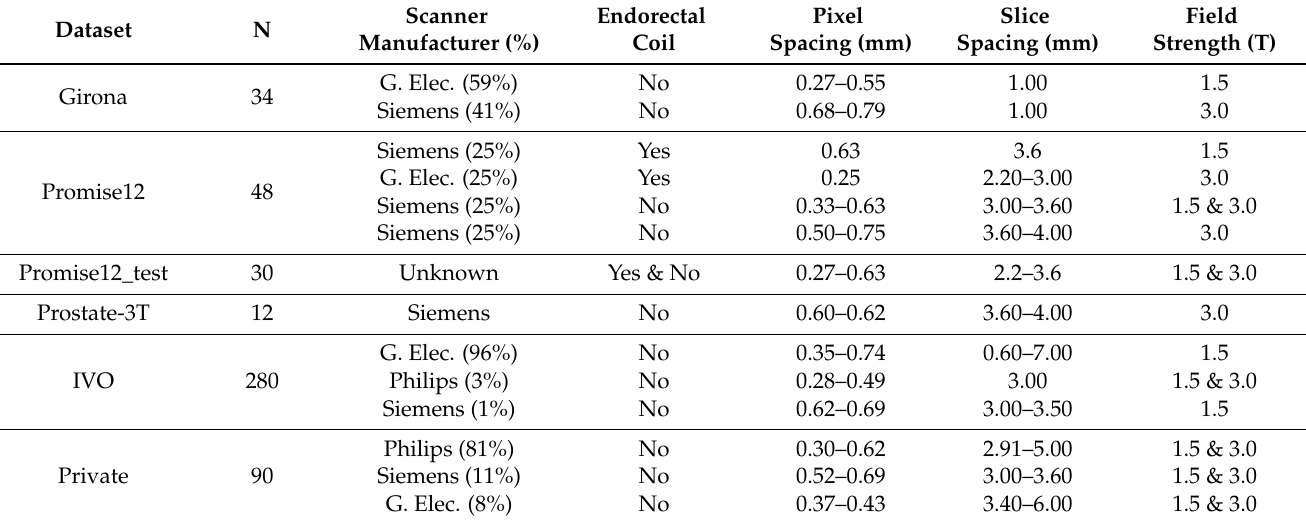
Table 1. Details of the MR datasets.